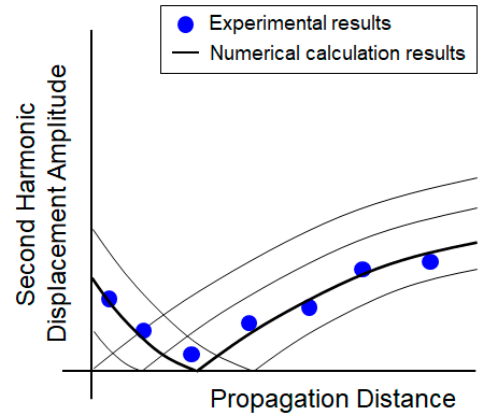
( z ) not equal (z) not (z) not 2 incident incident 2 incident